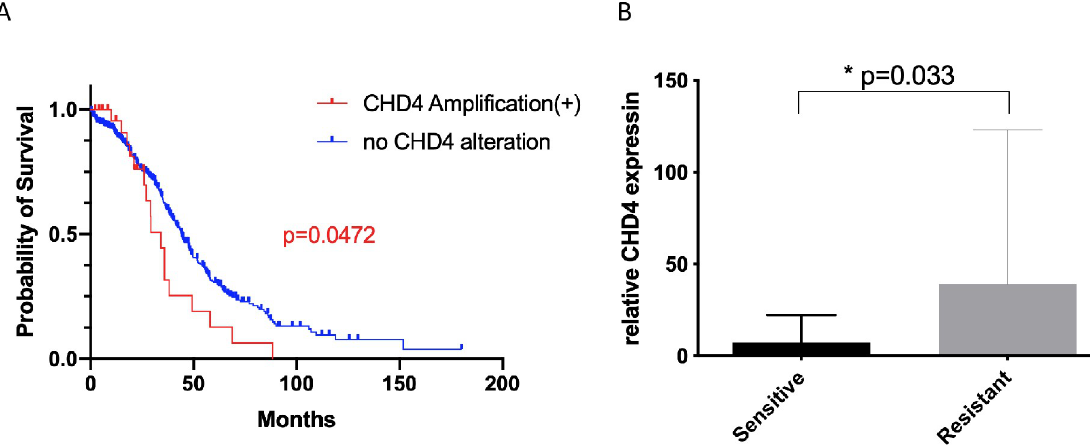
Fig 1. CHD4 amplification or higher expression is associated with worse survival or platinum sensitivity in patients with ovarian cancer. (A) Comparison of overall survival among the patients registered in the TCGA project with or without CHD4 amplification. Red and Blue curves represent overall survival in the patients harboring CHD4 amplification (n = 27) and the patients without CHD4 copy number alteration (n = 458), respectively. (B) CHD4 mRNA expression in platinum sensitive (n = 20) and platinum resistant (n = 6) patient